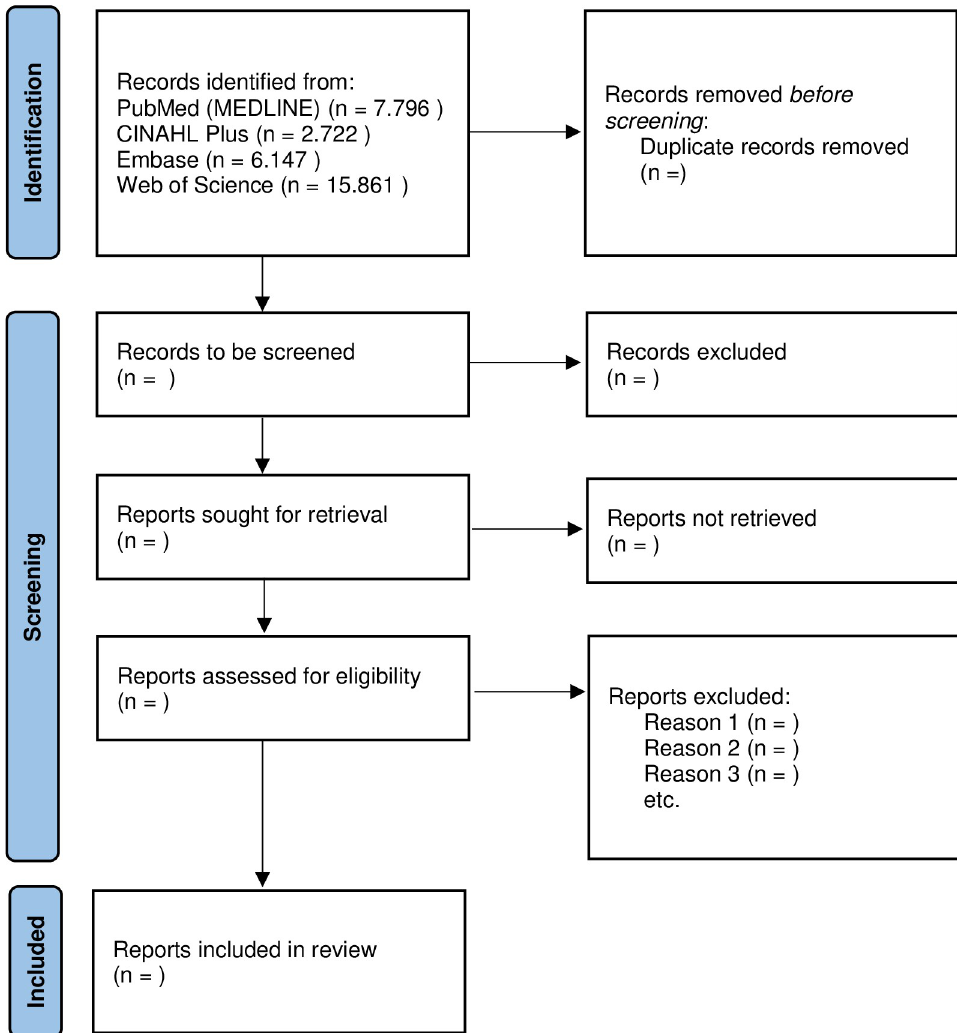
Fig 2. PRISMA flow diagram. The flow diagram shows the identification, screening, and inclusion of the identified records through PubMed (MEDLINE), CINAHL Plus, Embase, and Web of